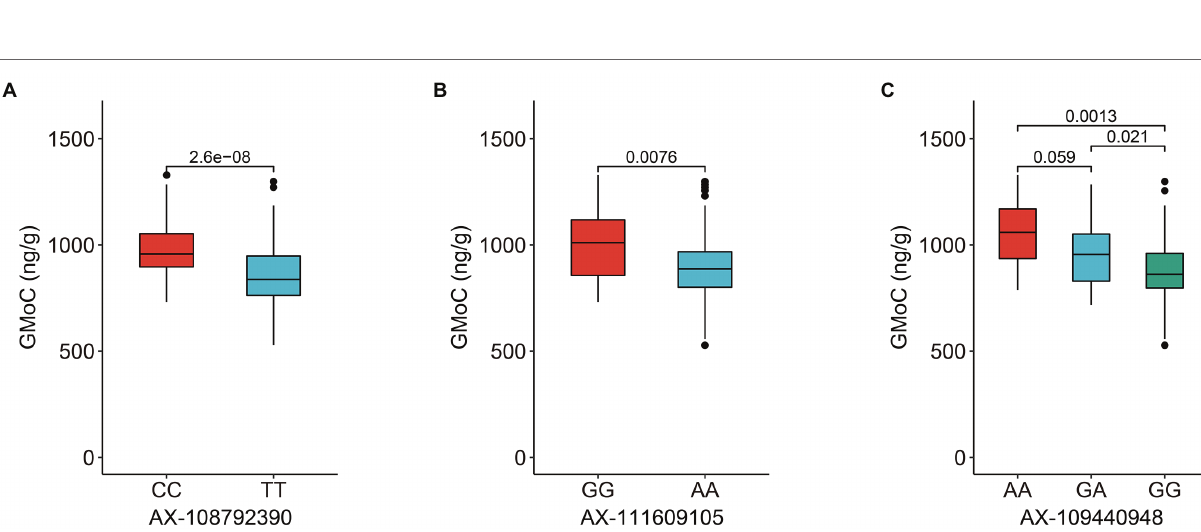
FIGURE 2 | Manhattan plots and QQ plots based on GWAS of GMoC by FaST-LMM model. (A) 2019, (B) 2020, and (C) BLUP values.